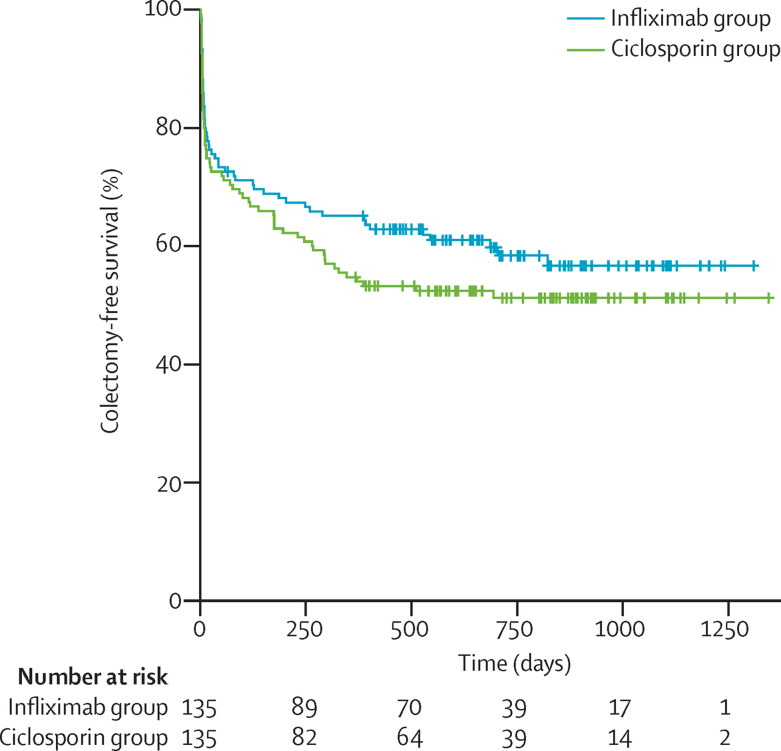
Time to colectomy